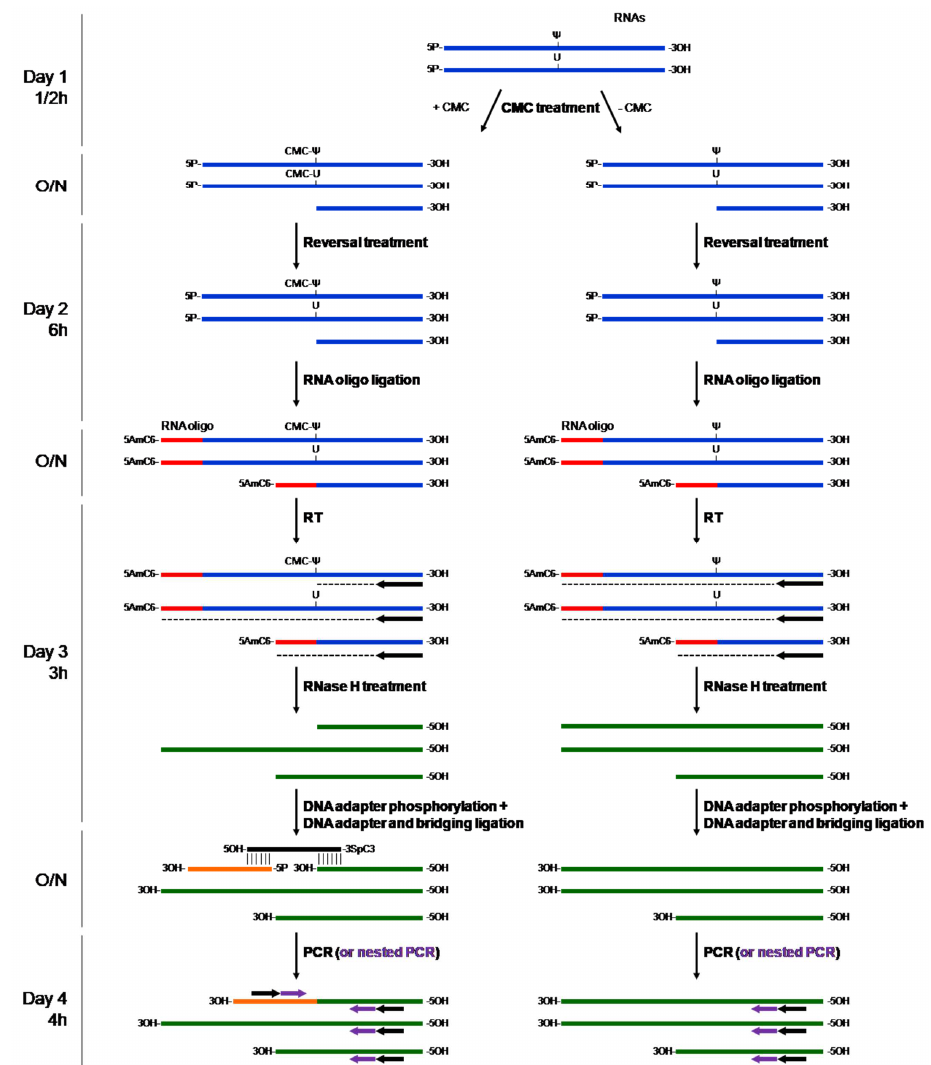
Figure 1. Principle of the CMC treatment followed by PCR. Total RNA was treated with either CMC (+CMC) or H 2 O (−CMC) for at least 16 h. Notably, random cleavage was produced during the treat- ment. Since an alkaline-reversal treatment was performed to remove the CMC-U, only the CMC-Ψ adducts remained. Next, a blocking RNA oligo was added at the 5′-end of the treated RNAs to pre- vent the potential fragmented RNAs from mimicking a RT-stop due to a CMC-Ψ adduct. After the reverse transcription (RT) and the RNase H treatment steps, a DNA adapter was added with the help of a bridging oligo, designed with DBO, which was half complementary to the 5′ end of the